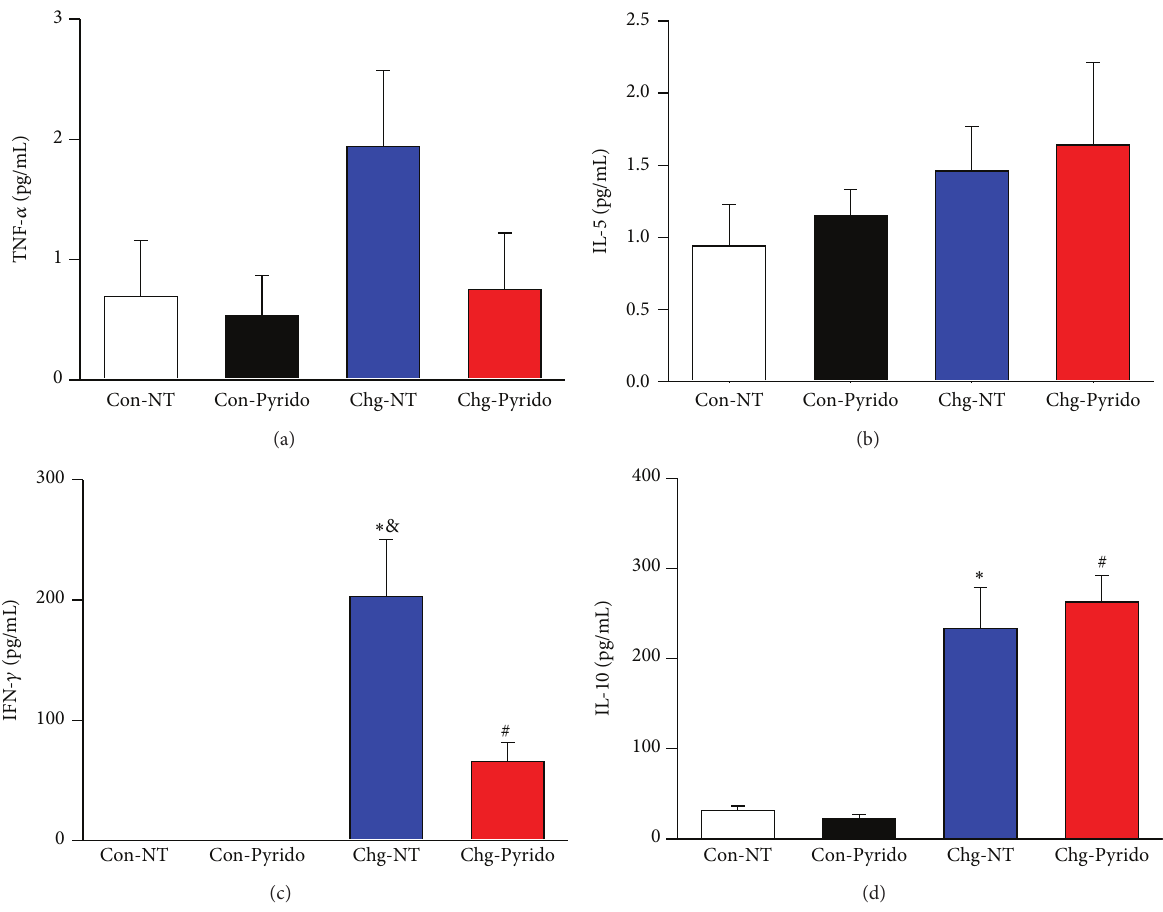
Figure 5: Serum cytokines after treatment with pyridostigmine bromide. Serum levels (in pg/mL) expressed as mean ± S.E.M. of tumor necrosis factor- 𝛼 (TNF- 𝛼 : Panel (a)), interleukin-5 (IL-5: Panel (b)) measured by the cytometric bead array technique, interferon- 𝛾 (IFN- 𝛾 : Panel (c)), and interleukin-10 (IL-10: Panel (d)) measured by ELISA at the 6th month of observation and after one month of treatment (from the 5th to 6th month of infection) in noninoculated control (Con) or T. cruzi- inoculated (Chg) C57BL/6j mice treated or not (NT) with pyridostigmine bromide (Pyrido). ( ∗ 𝑃 < 0.05 versus Con-NT; & 𝑃 < 0.05 versus Chg-Pyrido; and # 𝑃 < 0.05 versus